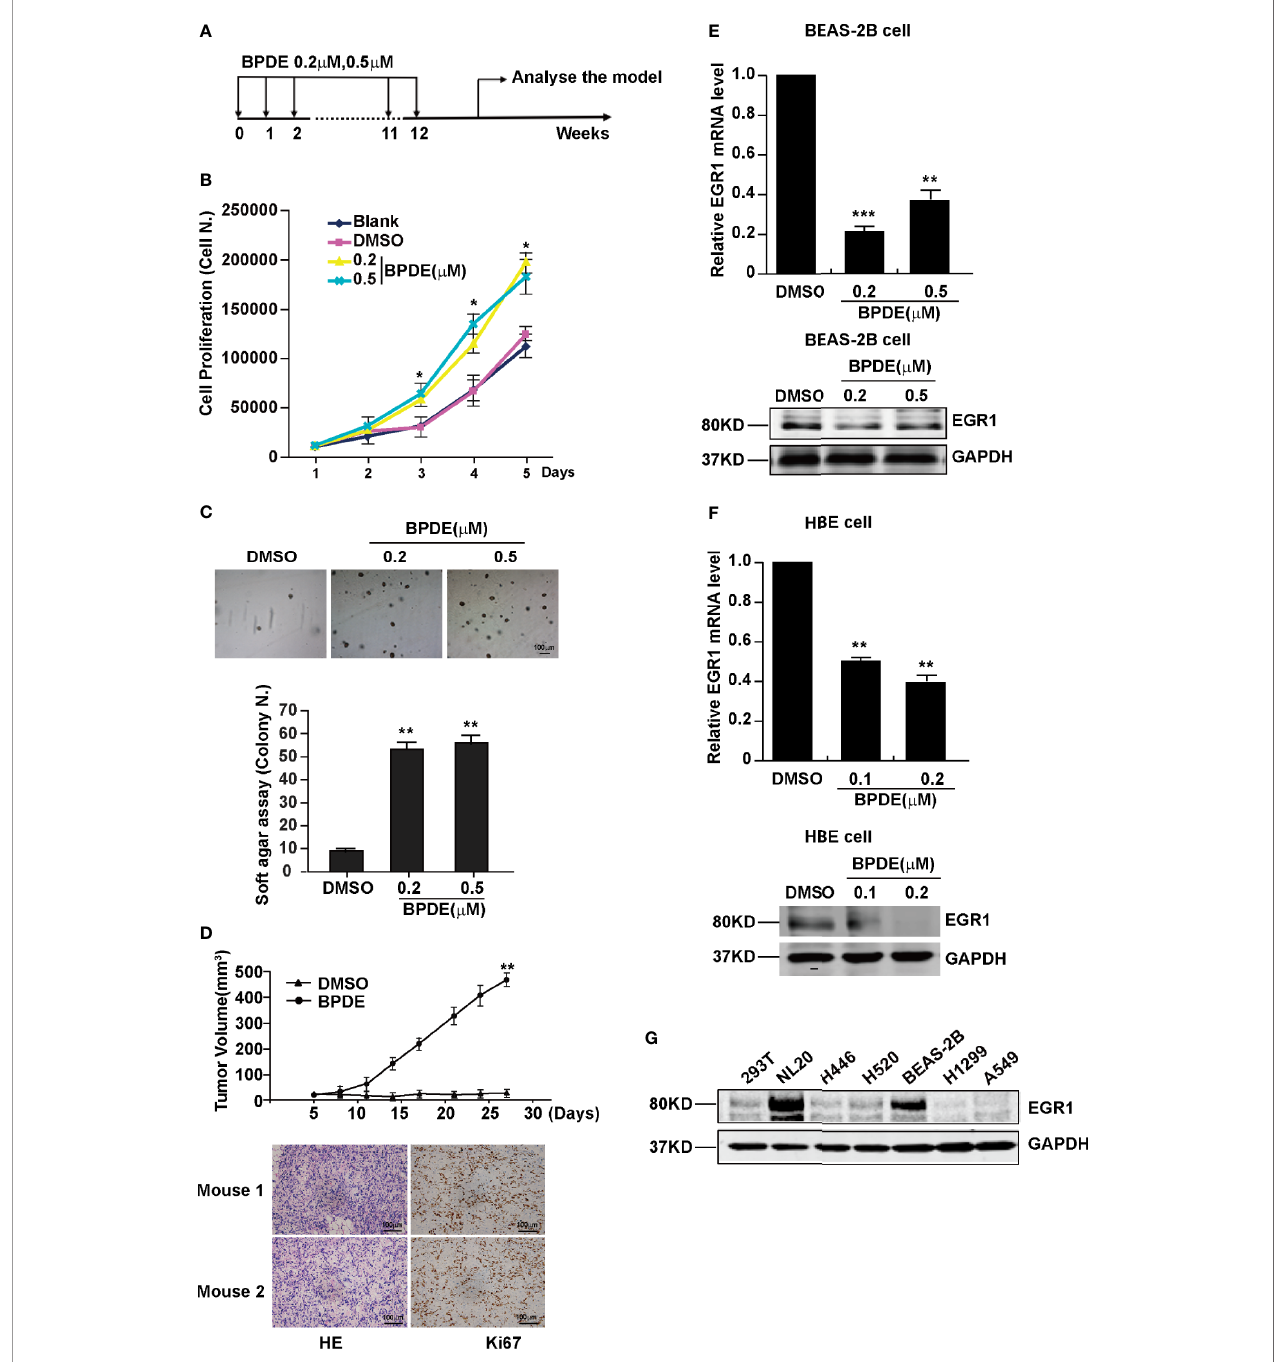
FIGURE 1 | EGR1 was downregulated in BPDE-induced malignant transformation of normal human lung epithelial cells. (A) Schematic map of BPDE-induced malignant transformation model. (B) Cell proliferation ability of BPDE-treated and control cells. (C) Cell anchorage-independent growth in soft agar. Top, representative images; bottom, quantitative results of cell colony per fi eld. (D) Top, Tumor growth curve of the transformed cells induced by BPDE and control cells injected subcutaneously in nude mice (n = 12 tumors per group); bottom, representative photos of the HE staining and Ki67 immunohistochemical staining of the tumor mass. (E, F) EGR1 expression analyzed by qRT-PCR and Western Blot in transformed BEAS-2B and HBE cells. (G) Egr-1 expression in different lung epithelial and lung cancer cells. Normal bronchial epithelial cell: NL-20, BEAS-2B; lung cancer cell: H446, H520, H1299, A549. The analyses were repeated three times, and the results were expressed as mean ± SD. * P < 0.05, ** P < 0.01 and *** P <